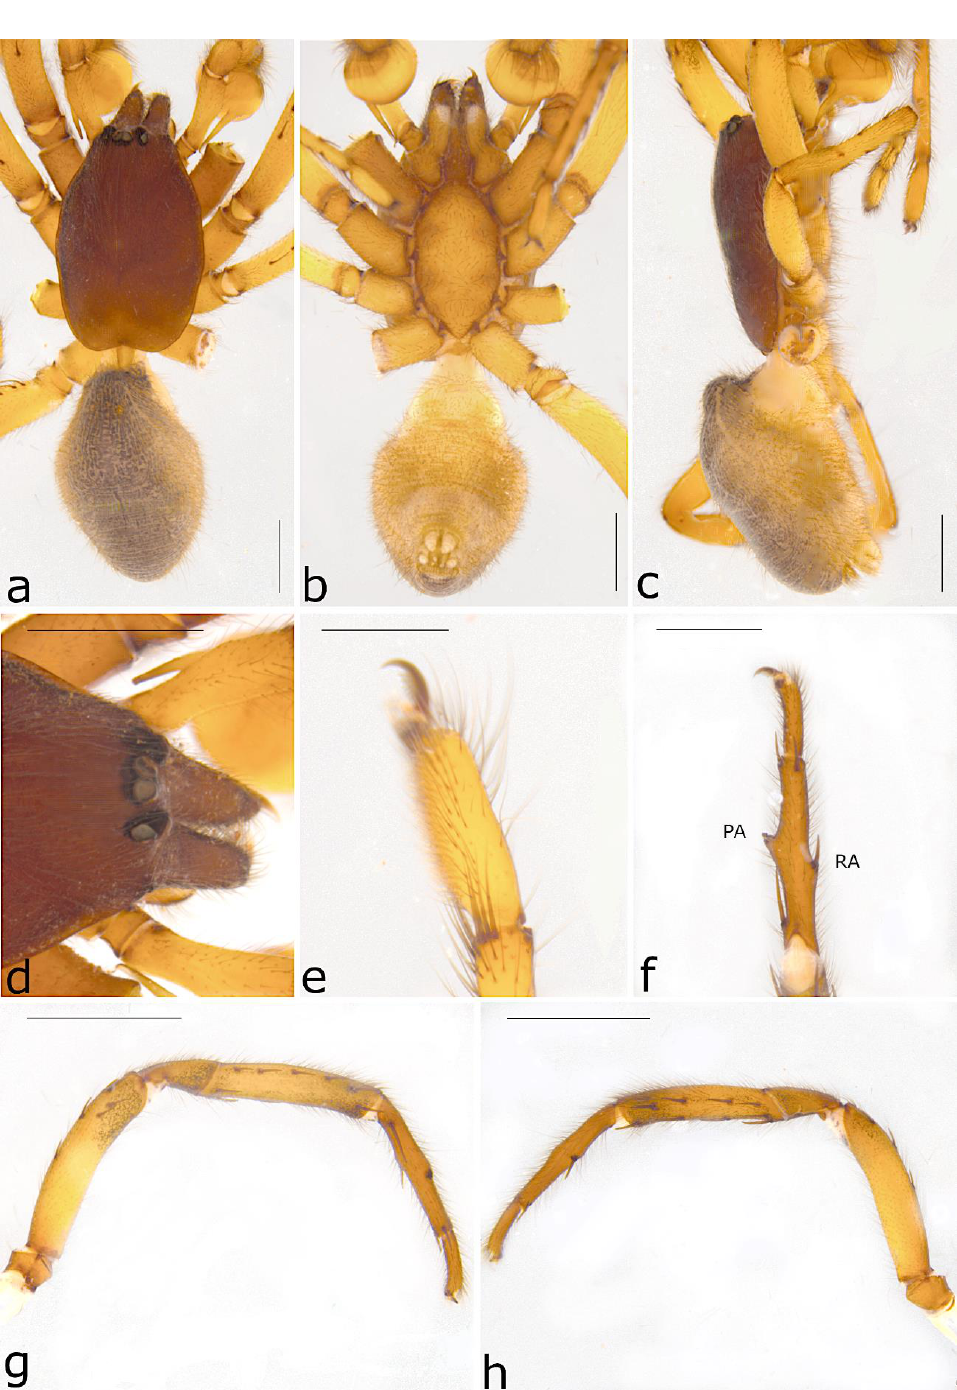
Figure 50. Ariadna rutila sp. nov. ♂ holotype (SAMA NN30477) from Muckera (SA): ( a ) habitus, dorsal view; ( b ) same, ventral view; ( c ) same, lateral view; ( d ) eyes, dorsal view; ( e ) left metatarsus IV, preening comb, retrolateral view; ( f ) left leg I, ventral view; ( g ) same, prolateral view; ( h ) same, retrolateral view. Scale bars ( a – d ) = 1 mm, ( e ) = 0.5 mm, ( f ) = 1 mm and ( g , h ) = 2 mm.